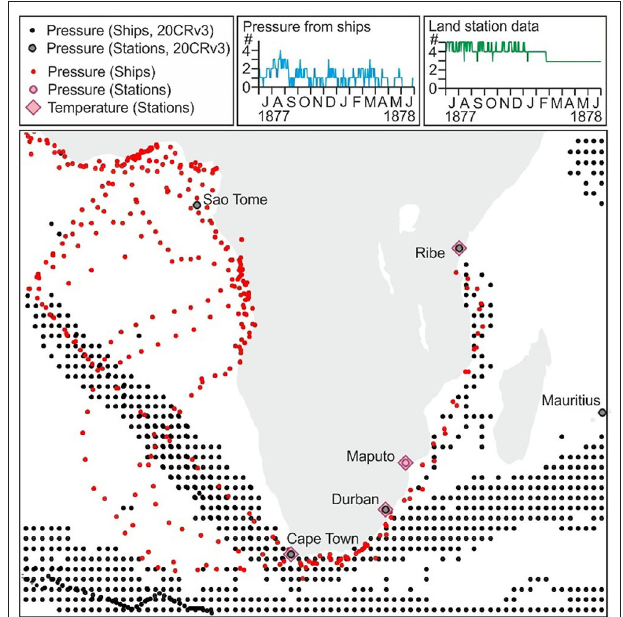
FIGURE 4 | Map of daily time series used in the experiments of the year 1807. Black dots (ships) and circles (stations) indicate the pressure series already assimilated into 20CRv3. The colored symbols indicate stations assimilated in this article. The lines indicate the numbers of ship and land station data assimilated per